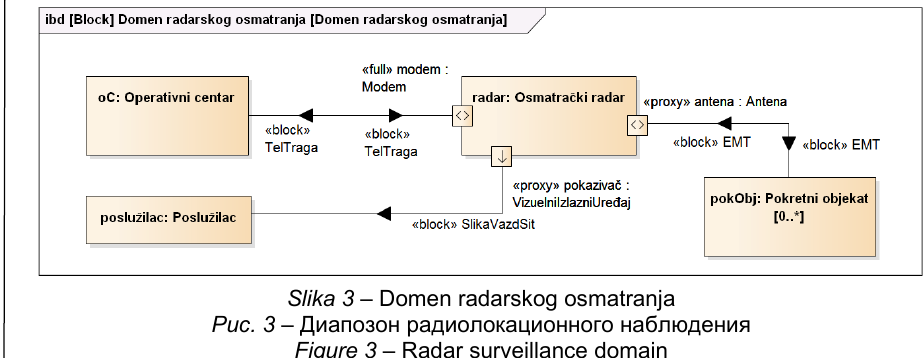
Рис . 3 – Диапозон радиолокационного наблюдения Figure 3 – Radar surveillance